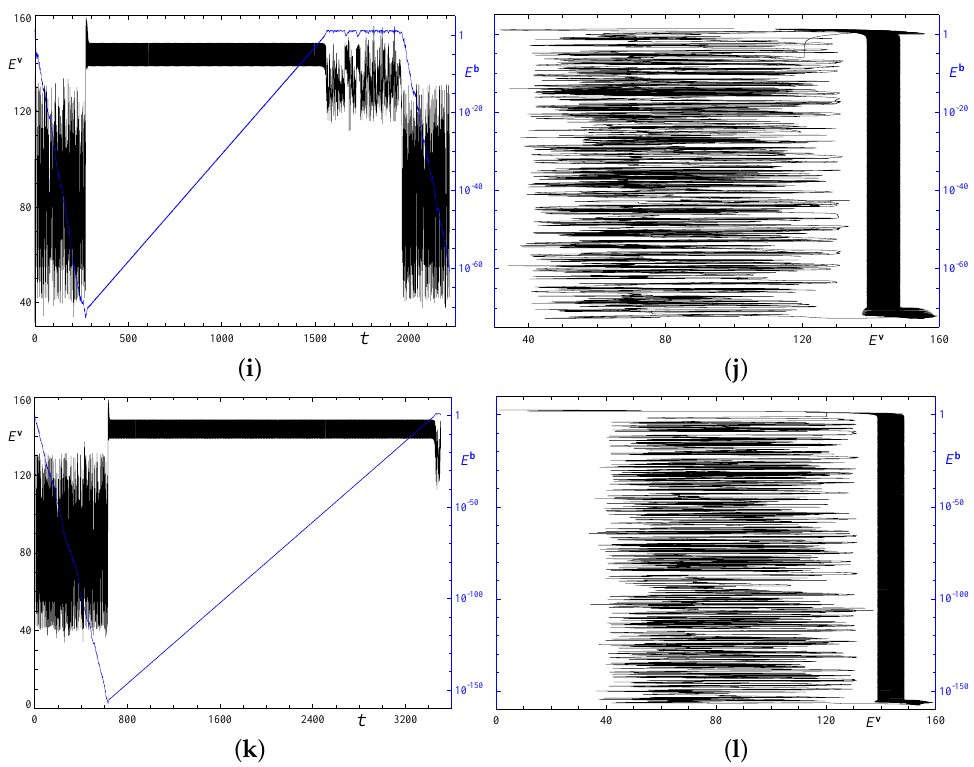
Figure 5. Temporal behaviour of the kinetic (left vertical axis, black line) and magnetic (right vertical axis, blue line) energies in the double-period runs 1 x 2.1 (a), 1 x 2.2 (c), 1 x 2.3 (e), 2 x 1.1 (g), 2 x 1.2 (i), and 2 x 1.3 (k). Evolution of the magnetic energy versus kinetic energy in runs 1 x 2.1 (b), 1 x 2.2 (d), 1 x 2.3 (f), 2 x 1.1 (h), 2 x 1.2 (j), and 2 x 1.3 (l). Table 4. Magnetic Reynolds number estimates in various phases of the runs in the double-period periodicity cells. Interval: the time interval, for which the magnetic Reynolds number estimates are computed; (cid:96) n : estimates (7) of the internal spatial scale of the perturbed regime; Rm n : the magnetic Reynolds number estimate based on (cid:96) n ; | v | : the characteristic flow velocity in the time interval under